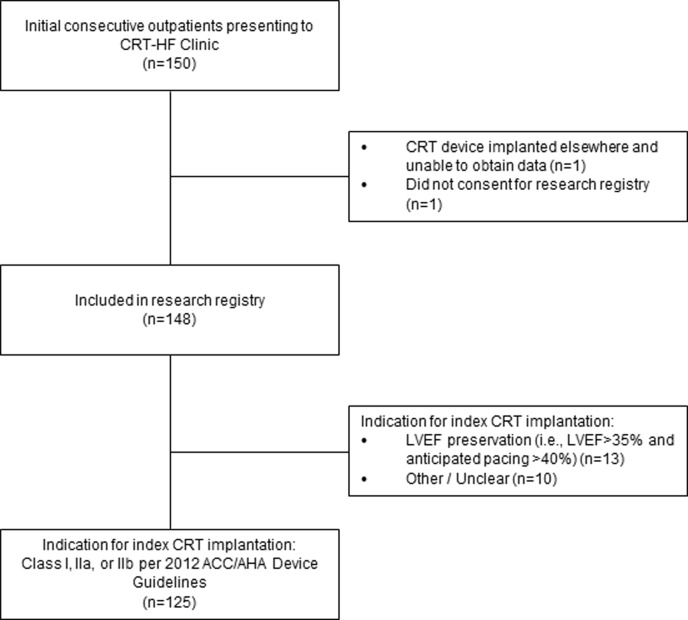
CONSORT diagram.